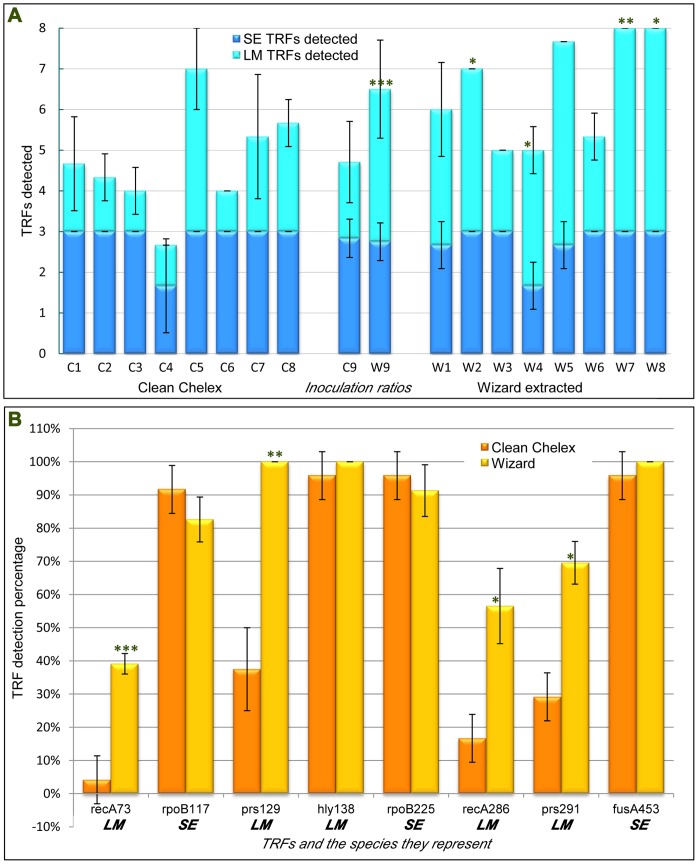
Terminal Restriction Fragment (TRF) detection for DNA extraction and post-amplification clean-up protocols for inoculated milk experiments.A: TRFs detected for both S. enterica (SE) and L. monocytogenes (LM), and are indicated as described in the legend, with three SE TRFs and five LM TRFs expected for all samples. TRFs detected are shown for the mean averages of three individual replicates in each case. Error bars shown are +/-1SD for both TRFs detected values. Milk was inoculated with five strains each of S. enterica (SE), E. coli (EC) and L. monocytogenes (LM) at 4.4, 3.2 and 5.4 cfu per 25 ml of milk respectively for the lowest level of initial inoculum (i.e. 10−7 dilutions) and tenfold this for 10−6 dilutions. These were used to make up inoculum ratios, shown as either Cn or Wn, where C indicates Chelex extracted and cleaned samples, W indicates Wizard extracted and uncleaned samples and n indicates ratios (SE:EC:LM respectively) as follows: 1, 1∶1:1 (10−7 dilutions); 2, 1∶1:1 (10−6 dilutions); 3, 10∶1:1; 4, 1∶10:1; 5, 1∶1:10; 6, 10∶10:1; 7, 10∶1:10; 8, 1∶10:10; 9, mean average of all corresponding samples. Paired student’s two-tailed t-tests were performed between all 9 corresponding C and W datasets for both SE and LM TRF types e.g. C1 LM TRF figures were paired and compared with W1 LM TRF figures. Asterisks at the top of the corresponding W bar indicate significant differences, with one asterisk indicating a P value of <0.02, two indicating P<0.01, and three indicating P<0.0001. B: Total specific TRF detection percentages across DNA extraction and post-amplification product clean-up treatments for pre-enrichment inoculum ratio experiments as above. Specified TRFs detected for both S. enterica (SE) and L. monocytogenes (LM), and are indicated as described. Error bars shown are +/-1SD for all data, derived from triplicate datasets. Paired student’s two-tailed t-tests were performed between corresponding Clean Chelex and Wizard extracted DNA datasets for all eight TRFs. Asterisks at the top of the corresponding bar indicate significant differences, with one asterisk indicating a P value of <0.05, two indicating P<0.02, and three indicating P<0.005.